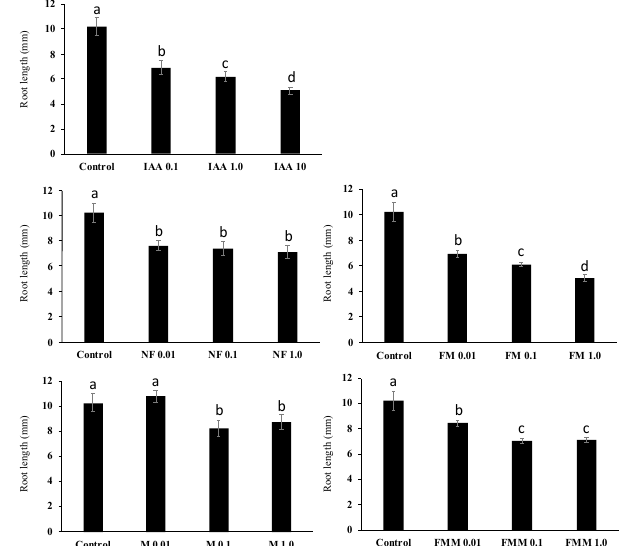
Figure 2. FT-IR spectra of humic substances (HS) extracted from earthworm coprolites collected in soils fertilized with no inputs (NF), or with manure (FM), mineral fertilizers (M) and with manure plus mineral fertilizers (FMM).